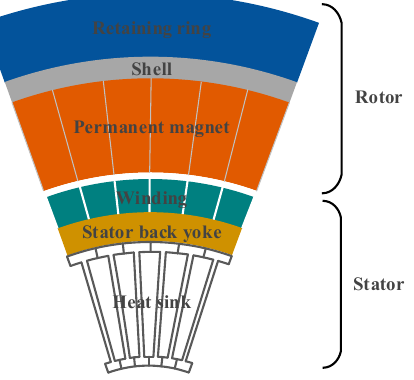
Figure 16. Structure of high-speed permanent magnet motor [116].